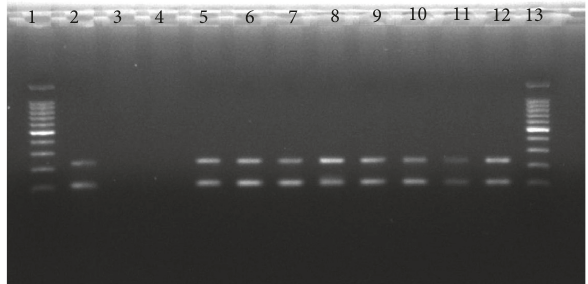
Figure 1: Multiplex PCR image of bacterial DNA extracted from isolated E. coli colonies of chicken meat and edible meat organs collected from retail shops and supermarkets in the North Western Province using LacZ3 and YaiO primers. Lanes; 1, 100-bp molecular marker (Vivantis, Malaysia); 2, Escherichia coli -positive control; 3, Escherichia coli -negative control; 4, technical negative control; 5–12, E. coli DNA isolated from chicken meat and edible organs from retail shops and supermarkets; 13, 100-bp molecular marker (Vivantis, Table 1: Prevalence of E. coli in chicken meat and edible organs sold at retail shops and supermarkets in the Kurunegala district. Source